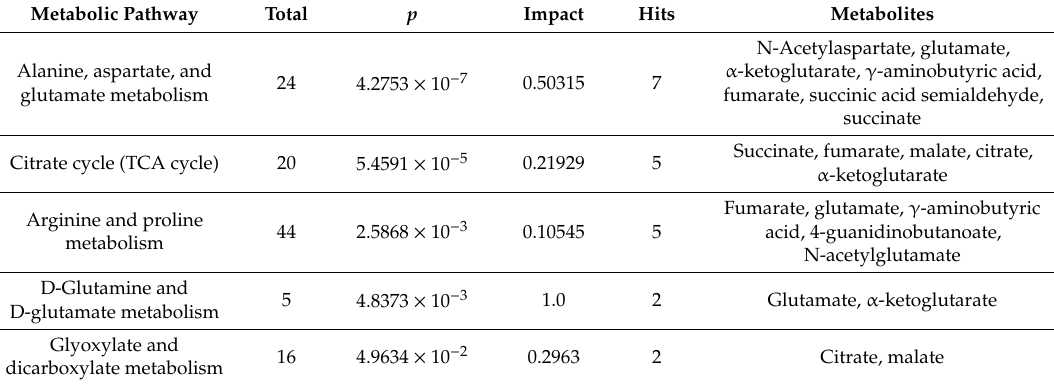
Table 3. Altered metabolism pathways following methamphetamine exposure Metabolic Pathway Total p Impact